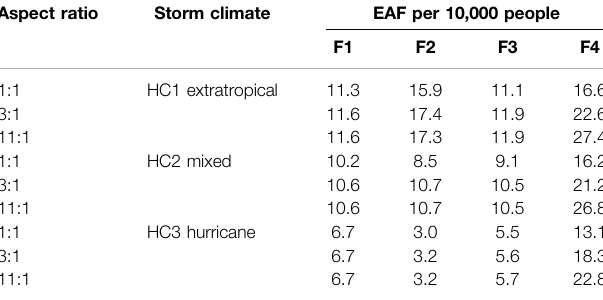
TABLE 2| EAF(percapita)for present-day without adaptation to reduce fl ooding. Aspect